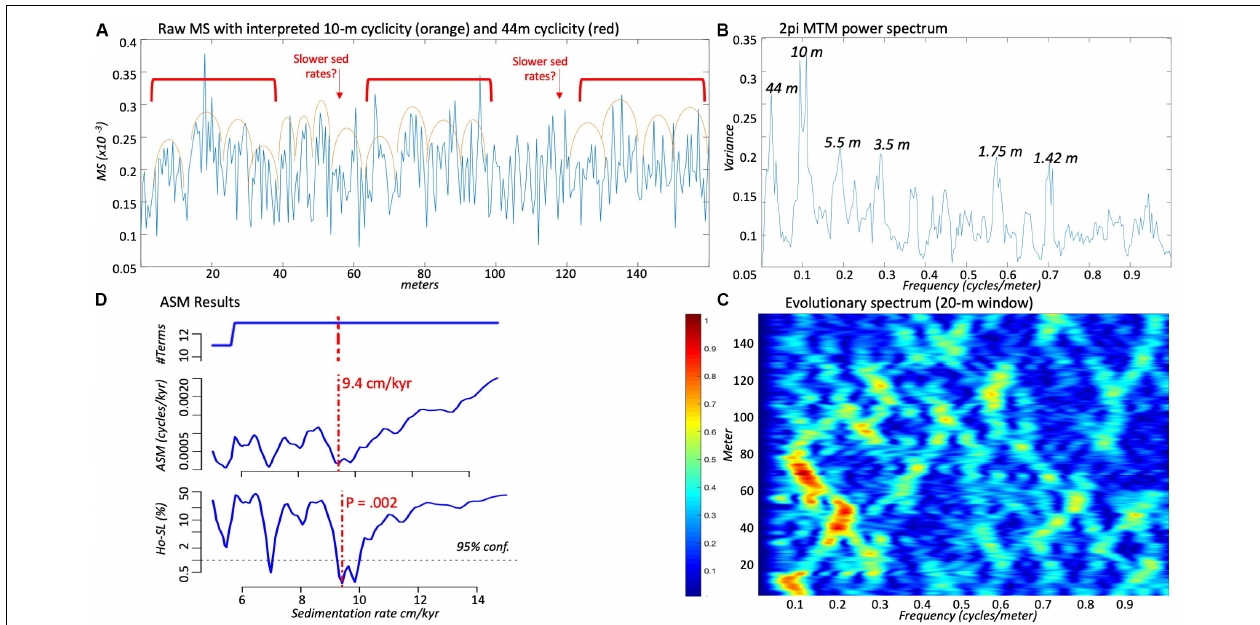
FIGURE 5 | Results of time series analysis and modeling for MS data collected in outcrop from the lower Salagou Formation (see stratigraphic context in Figure 3 ; lower bar). The section is measured in meters (from low to high is moving up-section). (A) Magnetic susceptibility data with interpretations shown by orange arcs [10 m cycles—short ( ∼ 100 kyr) orbital eccentricity] and red brackets [44 m cycles—long ( ∼ 405 kyr) orbital eccentricity]. (B) The power spectrum shows the proportion of power (or variance) as a function of frequency (in cycles/m). (C) The FFT spectrogram, computed with a 20 m running window. Warmer (red) colors represent high power and cooler (blue) colors low power. (D) Results of ASM analysis with the optimal sedimentation rate identified by the vertical red dashed curve. Top : number of astronomical frequencies used in the fit; middle : ASM statistic; bottom : statistical significance of Monte Carlo modeling with the critical level shown by the horizontal black dashed